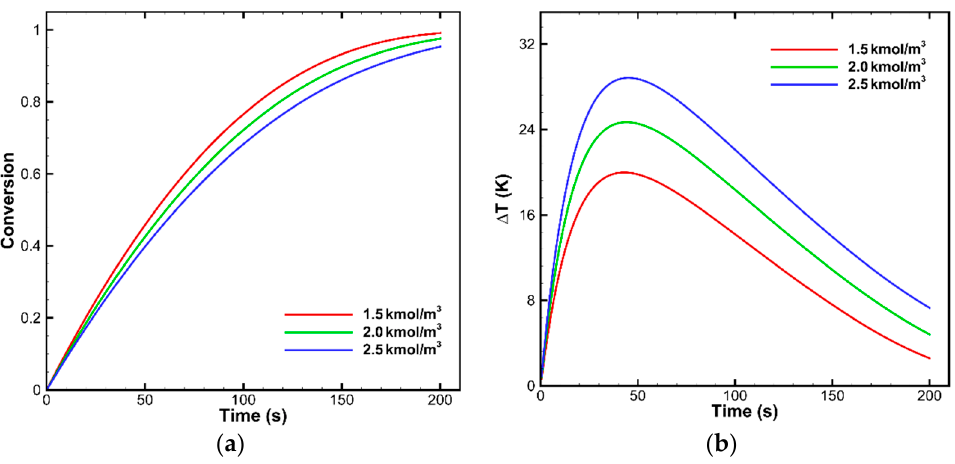
Figure 5. The profiles of ( a ) overall conversion and ( b ) ∆ T at various oxygen carrier load over